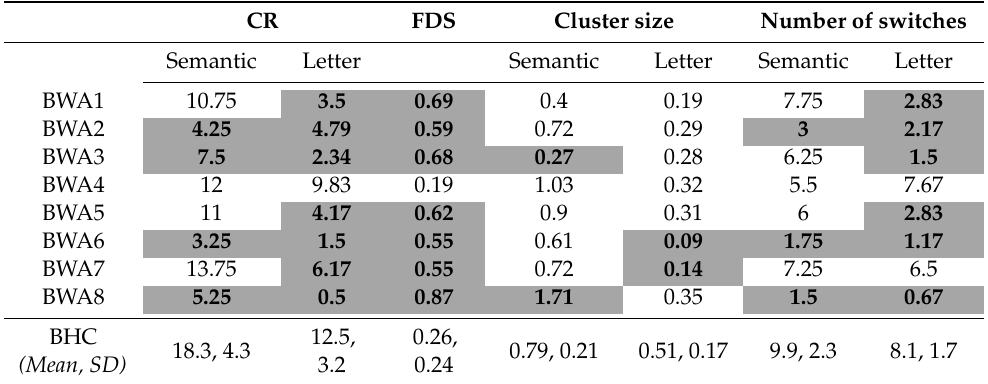
Table 7. Raw score of each BWA in semantic and letter fluency condition (averaged across languages) for number of correct responses (CR), fluency di ff erence score (FDS), cluster size, and number of switches, and statistical results for each BWA when compared to controls